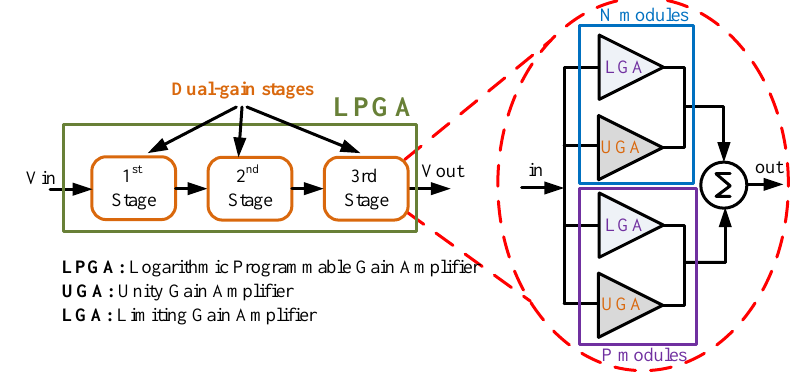
Figure 3. Block diagram of the proposed rail-to-rail LPGA.